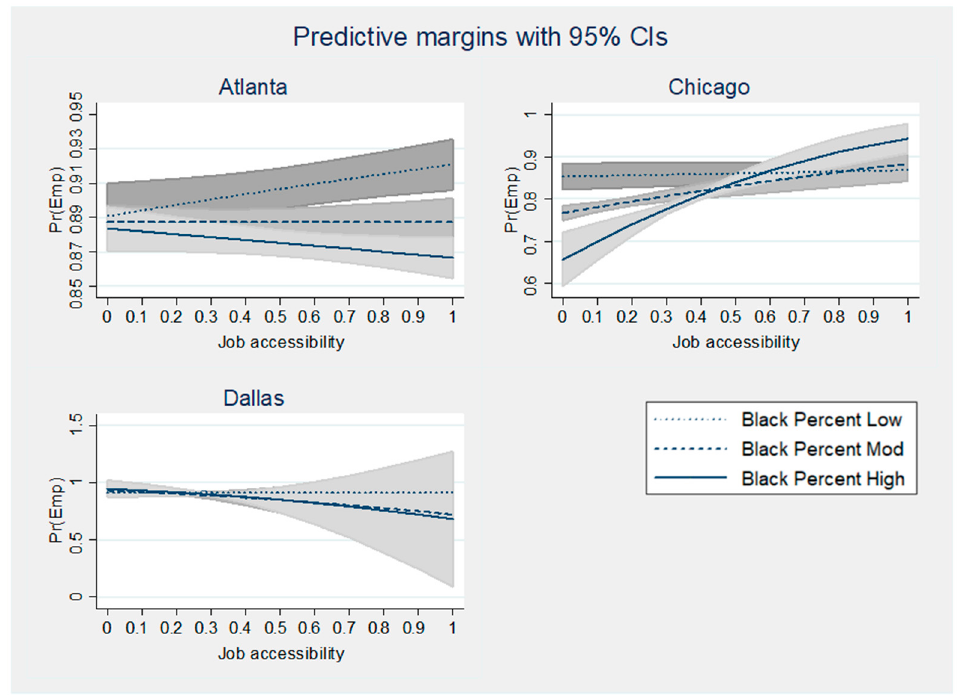
Figure 3. Predictive margins of employment outcome over neighborhood Black share with 95% confidence intervals.